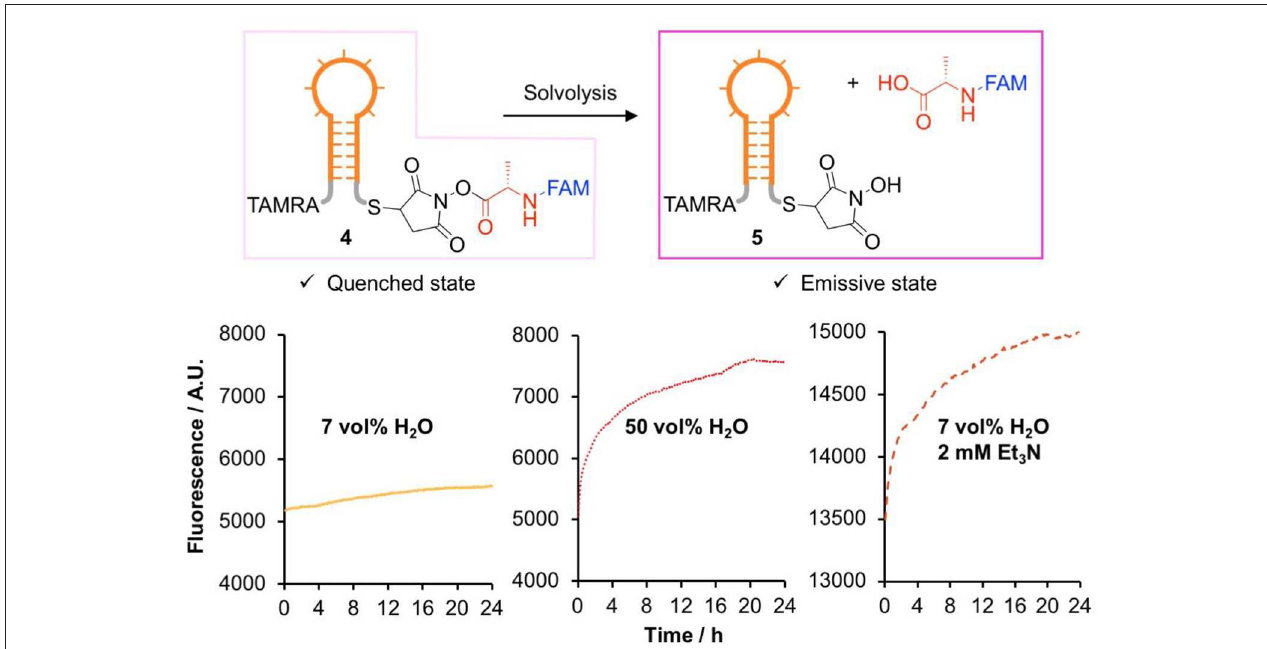
FIGURE 2 | Comparison of the stability of DNA-conjugated N -hydroxysuccinimide esters in several glycholine mixtures studied by fluorescence dequenching.